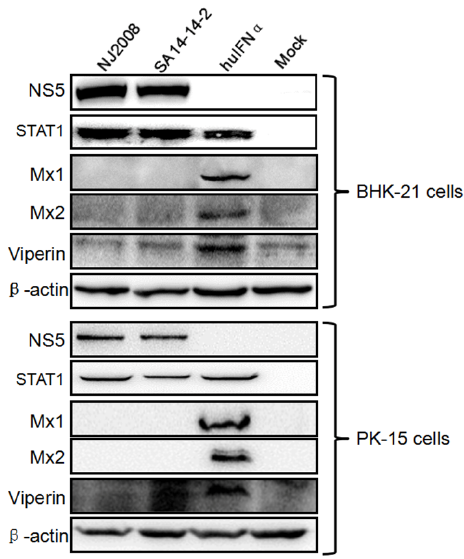
Figure 1. Japanese encephalitis virus (JEV) inhibits the production of interferon-stimulated gene (ISG) proteins. Cells were infected with JEV NJ2008 or SA14-14-2 strain at a multiplicity of infection (MOI) of 0.05. Alternatively, cells were treated with 200 ng/mL human interferon- α (huIFN α ) for 12 h at 37 ◦ C. After these treatments, ISG proteins in cell lysates were probed with the indicated antibodies using Western blot analysis.